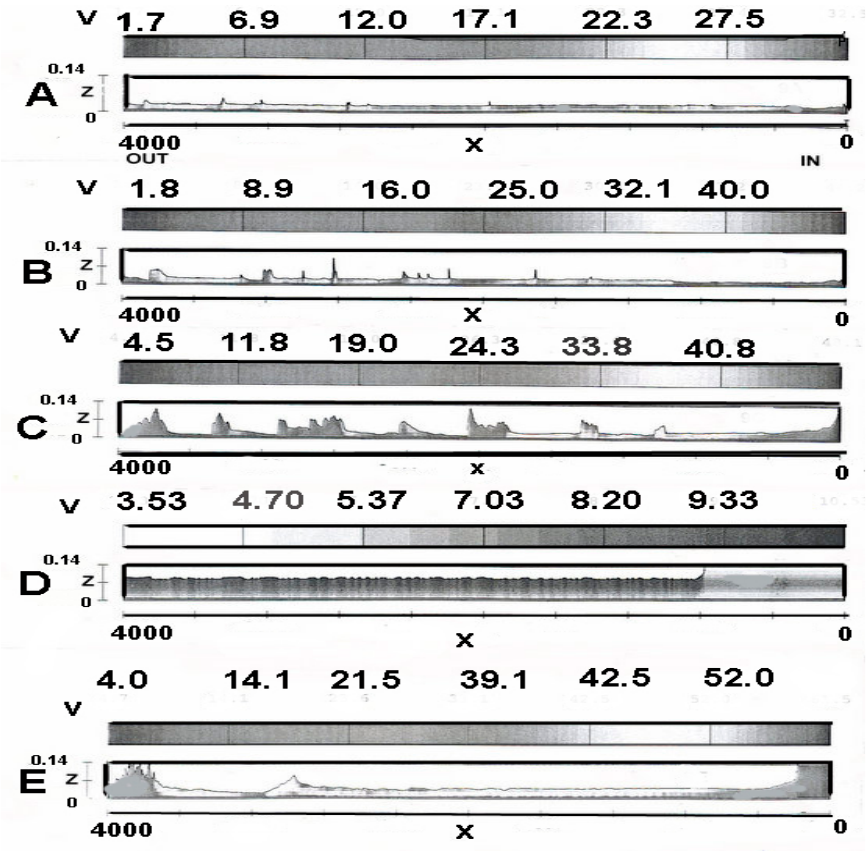
Figure 11. Internal pipeline flow stability results relevant to the Outer Siq pipeline for Cases A to E ; right (IN) to left (OUT) flow direction for all cases.